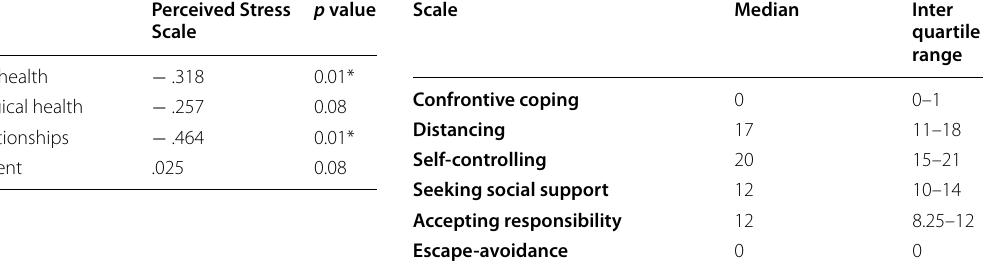
Table 4 Mann-Whitney U test for duration of illness (DUI) and “ways of coping in patients of schizophrenia with symptomatic